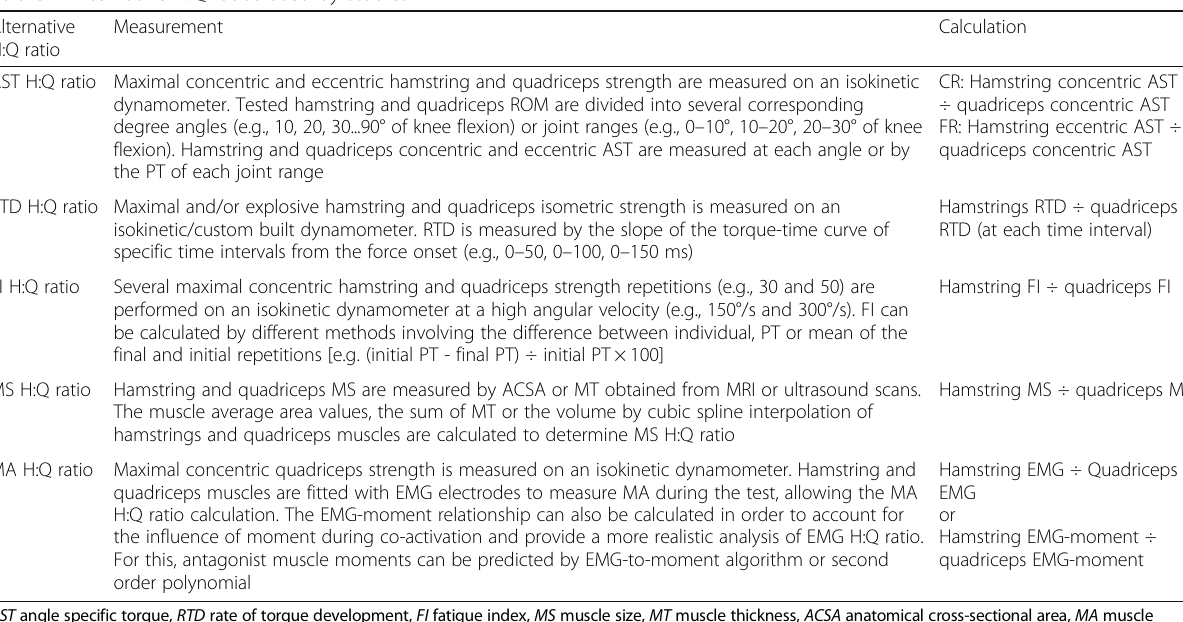
Table 2 Alternative H:Q ratios used by studies Alternative Measurement H:Q ratio